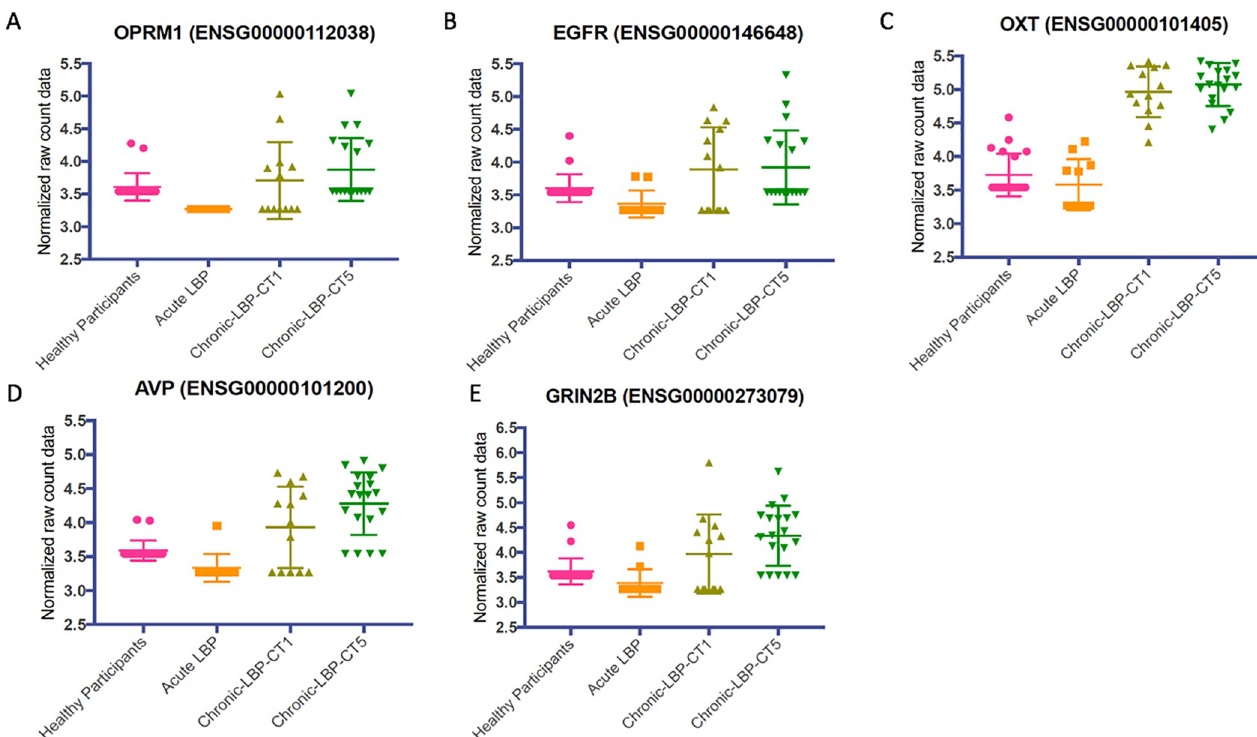
Fig 5. The whole blood gene expression levels for known or suspected pain genes that were members of major clusters from String 10 protein-protein interaction analysis were plotted. The analysis demonstrates that levels of each gene are differentially higher in the chronic T1/chronic T5 patients compared with acute and normal control participants. In each panel, the raw, normalized, non-zero gene expression counts from DESeq analysis are displayed as a scatter plot for each cohort. Symbols indicate individual expression levels for each of the N = 64 participants. A Kruskal-Wallis 1-way ANOVA was used to examine comparisons. In all cases, the expression levels for each gene were higher in the chronic T1 and chronic T5 groups compared with normal control participants and the acute group. (A) Opioid receptor mu 1 ( OPRM1 ) gene (H = 27.64, p < 0.0001). (B) Epidermal growth factor receptor ( EGFR ) gene (H = 15.29, p = 0.0016). (C) Oxytocin ( OXT ) gene (H = 47.43, p < 0.0001). (D) Arginine vasopressin ( AVP ) gene (H = 31.44, p < 0.0001). (E) Glutamate ionotropic receptor NMDA type subunit 2B ( GRIN2B ) gene (H = 24.25, p <